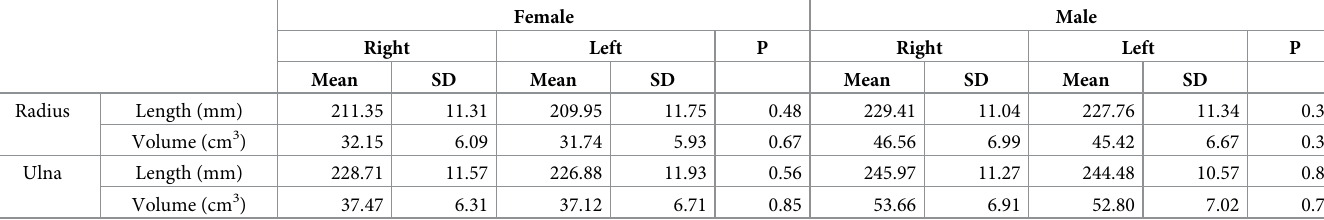
Regional shape difference analysis of the radius and ulna A. Radius. 1. Proximal Bilateral shape differences for the upper section of radii ranged from 0.01 mm to 3.18 mm. In the middle and lower sections of the proximal part, measurement values ranged from 0.00 mm to 2.77 mm for the middle section, and 0.00 mm to 3.27 mm for the lower section. Statistically significant shape differences between sides were not found in the upper to lower section of the proximal part (Fig 5). Table 2. Differences of length and volume between sides. Female Male Right Left P Right Left P Mean SD Mean SD Mean SD Mean Volume (cm 3 )